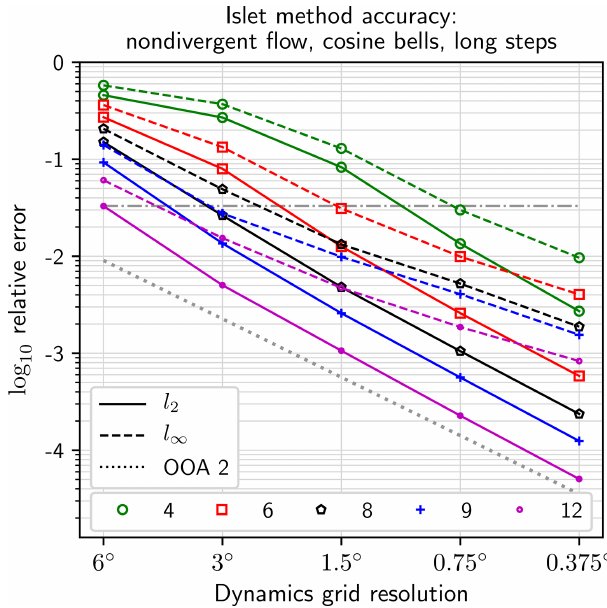
Figure 8. Accuracy diagnostic. Compare with Fig. 16 in